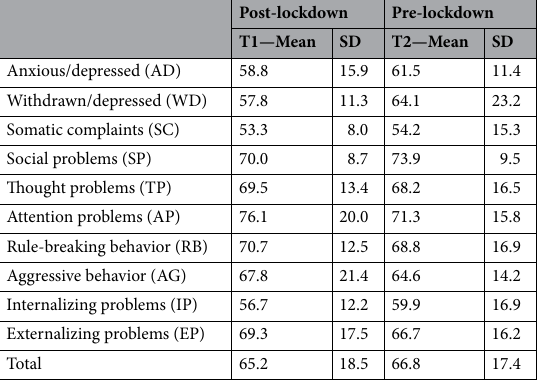
Table 3. Values of T-score ratings of CBCL syndromes for pre- and post-lockdown